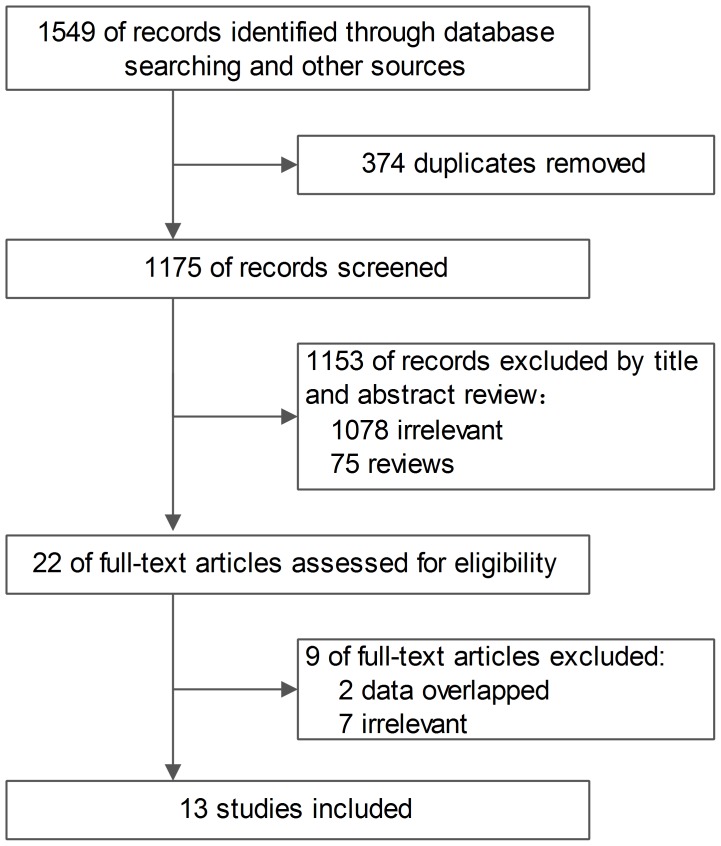
Study flow diagram.